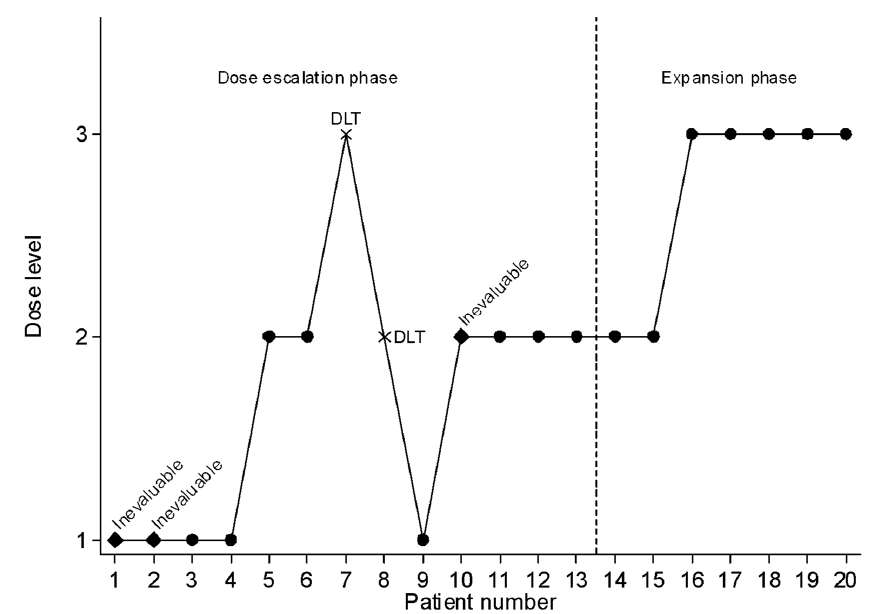
Figure 2. Sequential inclusion of patients with the allocated dose level. The median age of patients at inclusion is 12.5 years, with a median time from the Table 1. Characteristics of the 20 patients. initial diagnosis to registration in the study of 29 months (range: 3–173). Ten patients (50%) had an HGG, and ten patients (50%) had an LGG, including three NF1 patients.